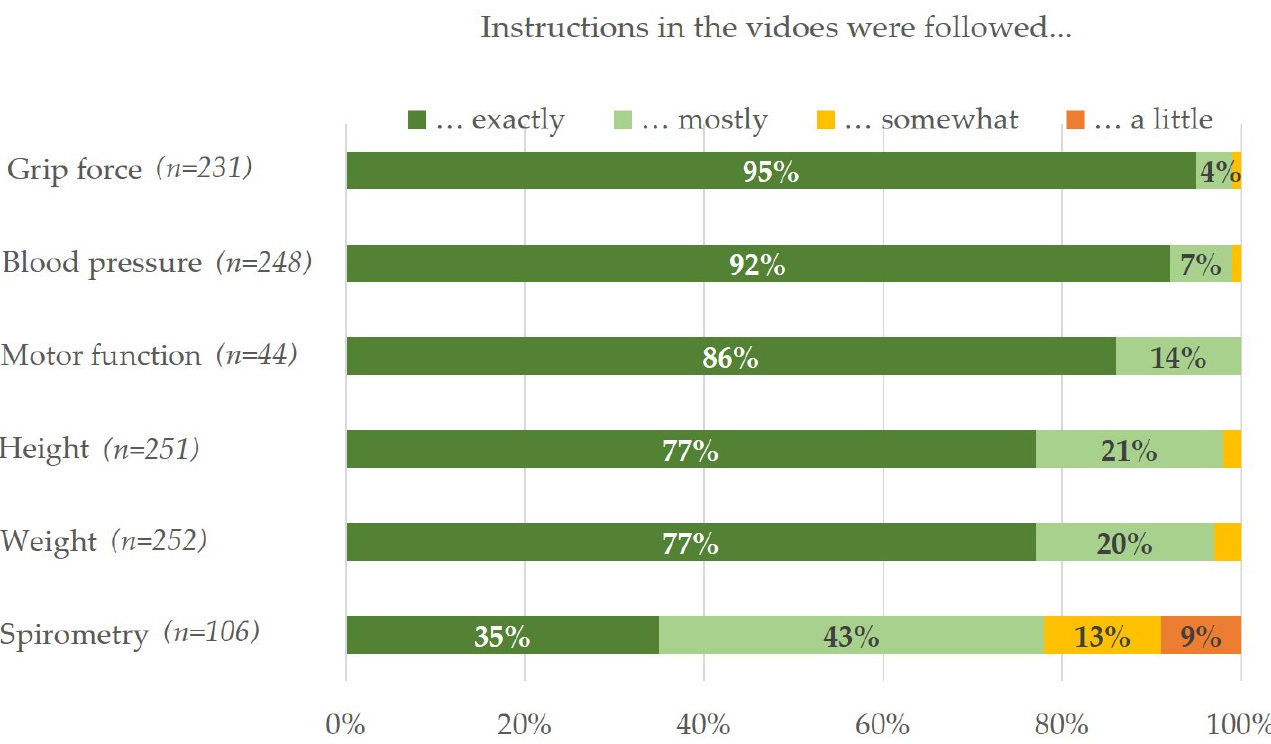
Figure 1. Evaluation of study personnel for how the participants followed instructions that were explained in the videos in terms of the different examinations.